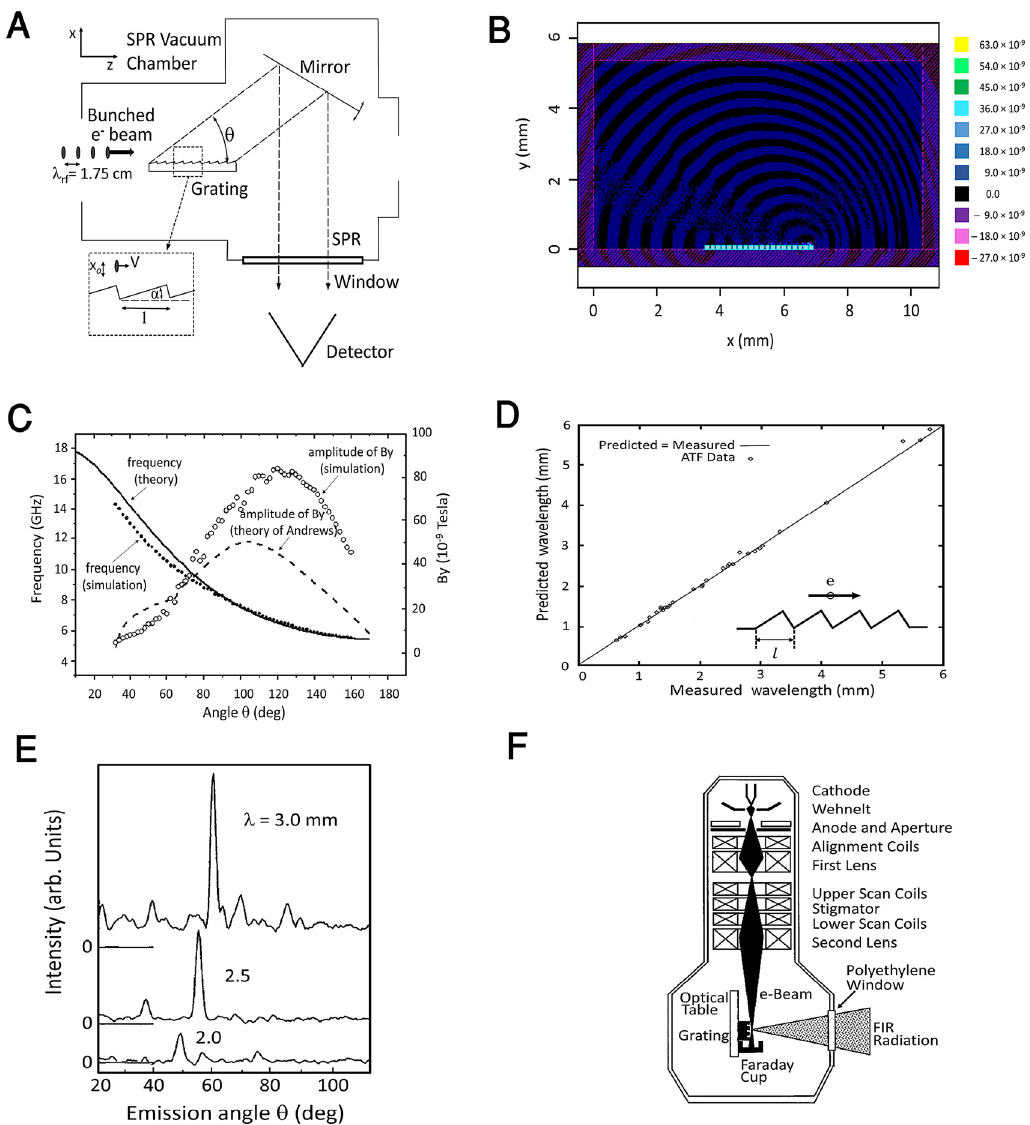
Figure7: (A)SPradiationexperimentalsetup.Thetrainofbunchedelectronsistravelingalongthe z directionaboveametallicechellegrating. Thediffractedradiationismeasuredbyadetectorlocatedoutsideofthevacuumchamber[22].(B)Crescent-shapedwavefrontsofcoherentSP radiation observed via the contour plot of the magnetic fi eld B z at t = 65.6 ps [146]. (C) The dependence of SP frequency and amplitude of the magnetic fi eld B y on the emission angles, observed at distances 36.35 cm from the center of the grating [148]. (D) Wavelength measurements foraluminumwith30 ° blazegratingwhichhasperiodsof1,2,4mmand20 ° blazegratingwithperiodsof2,4mmforanglesbetween18 ° – 40 ° . The plot showsgoodagreementbetweenpredictedand experimentalwavelength [150].(E)Dependenceof thecoherentSPradiation intensity on the emission angle. The intensity was measured with the 42 MeV short-bunched electron beam passing over a 6 mm period grating at the wavelengths 2.0, 2.5, and 3.0 mm [156]. (F) Schematic of the modi fi ed scanning electron microscope for generating coherent SP [157]. SP, surface